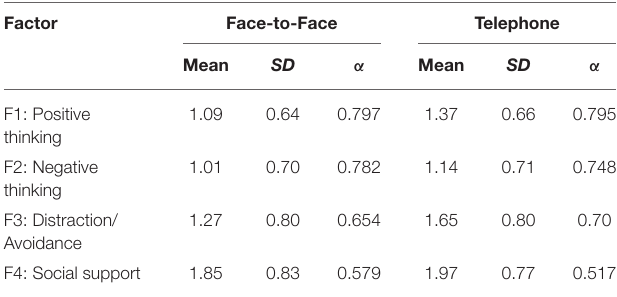
TABLE 2 | Mean score, deviation, error and internal consistency among factors and